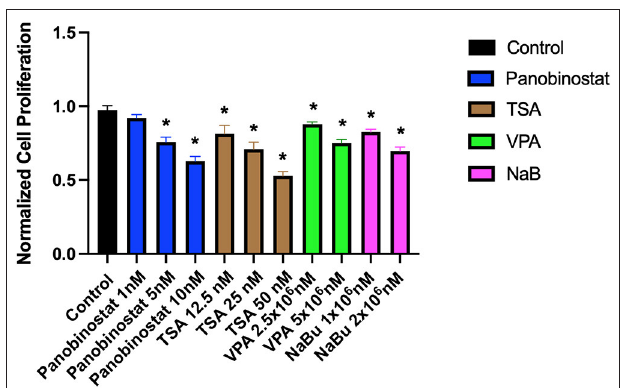
FIGURE 2 | Identification of a narrow range of HDACi concentration that does not impact CEF proliferative rate. CEFs were treated with a narrow range of HDACi concentrations for 72h. Each experiment was conducted six times using three different CEF lines. Data were normalized to non-treated control. Data are presented as mean ± SEM. Two-stage step-up method of Benjamini, Krieger, and Yekutieli for controlling false discovery rate was used for multiple comparison corrections. *False discovery rate adjusted p <